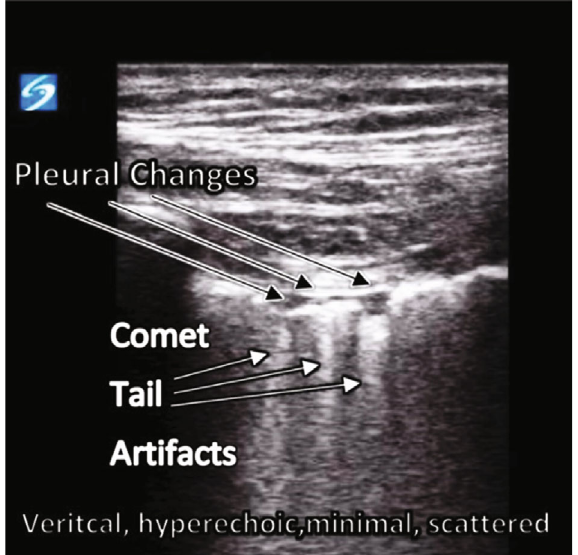
Figure 2: Con fl uent comet tail artifacts, as an example of interstitial edema, present in COVID-19 patients. This image is similar to the patient in this case study; however, it is not the same patient.